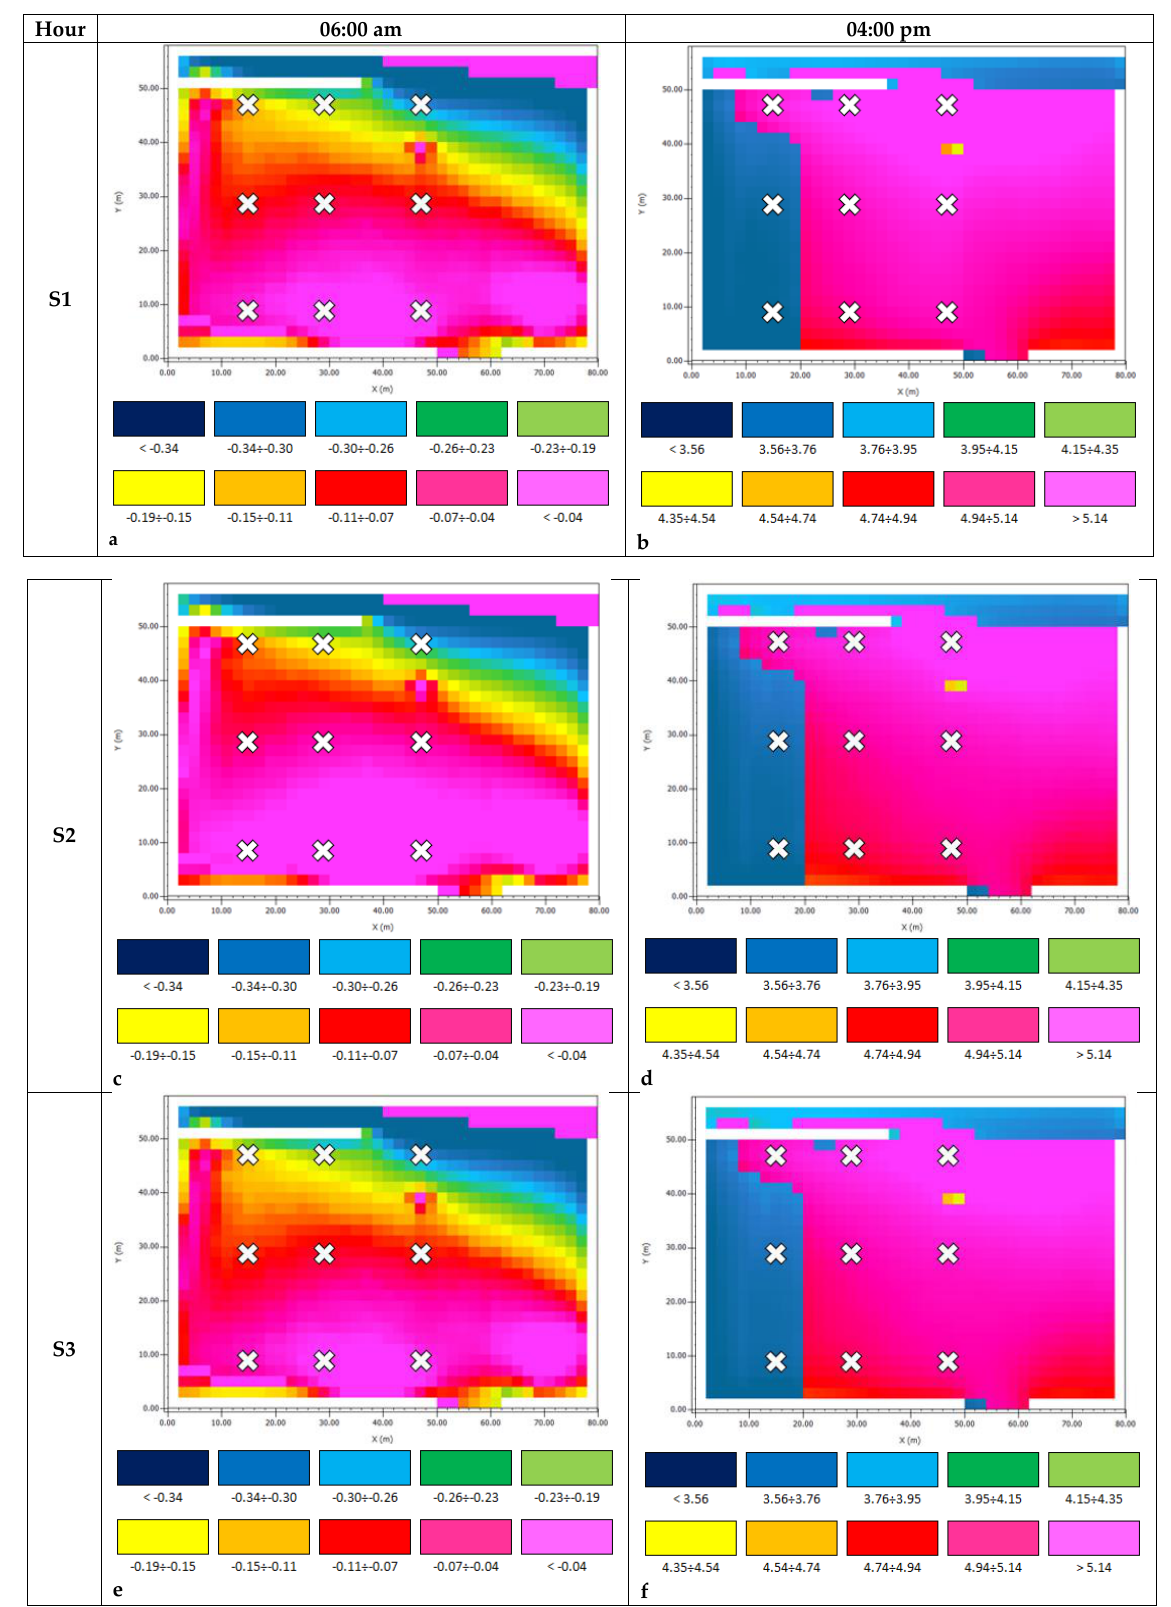
Figure 16. AT output maps. ( a ) S1 06:00 a.m.; ( b ) S1 04:00 p.m.; ( c ) S2 06:00 a.m.; ( d ) S2 04:00 p.m.; ( e ) S3 06:00 a.m.; ( f ) S3 04:00 p.m.